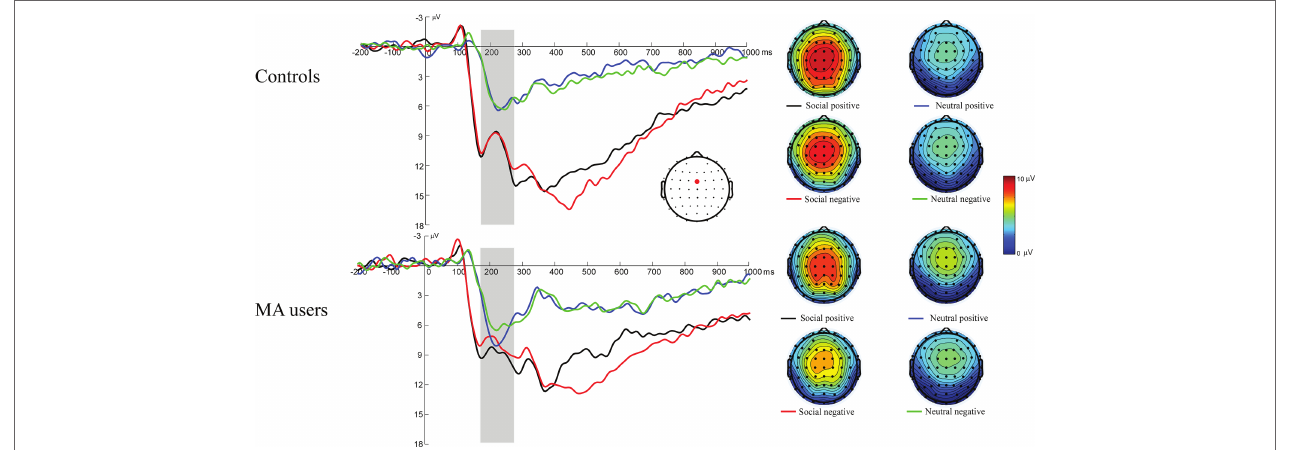
FIGURE 3 | Left: FRN responses to social positive, negative feedback on SID. Feedback onset was at 0 ms. The FRN was scored as the average activity in the shaded window (175–275 ms). Right: The scalp distributions of the ERP responses to positive and negative feedback on SID.